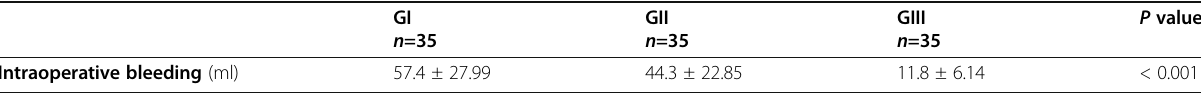
Table 3 Intraoperative bleeding in the studied groups